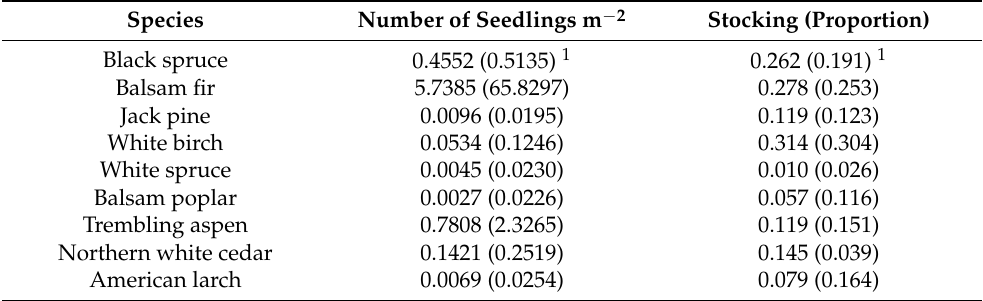
Table 6. Average potential number of seedlings per m 2 and stocking values for each species provided as input for the sample plots in the initialization files. Species Number of Seedlings m − 2 Stocking (Proportion) Black